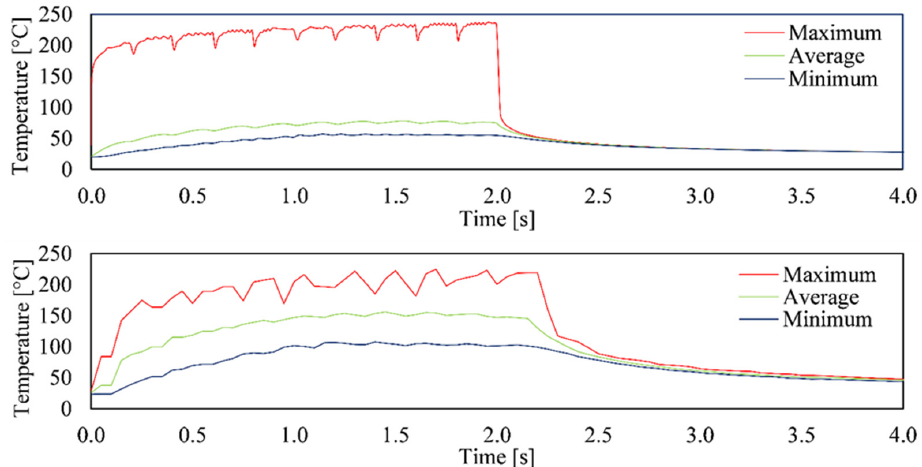
Figure 4. Comparison of the simulated (top) and experimentally (bottom) determined temperature curves for a 10 × 10 array with a separation of 100 µm. The holes were drilled with an average power curves for a 10 × 10 array with a separation of 100 µ m. The holes were drilled with an average power of 0.8 W and a drilling time of 0.02 s. of 0.8 W and a drilling time of 0.02